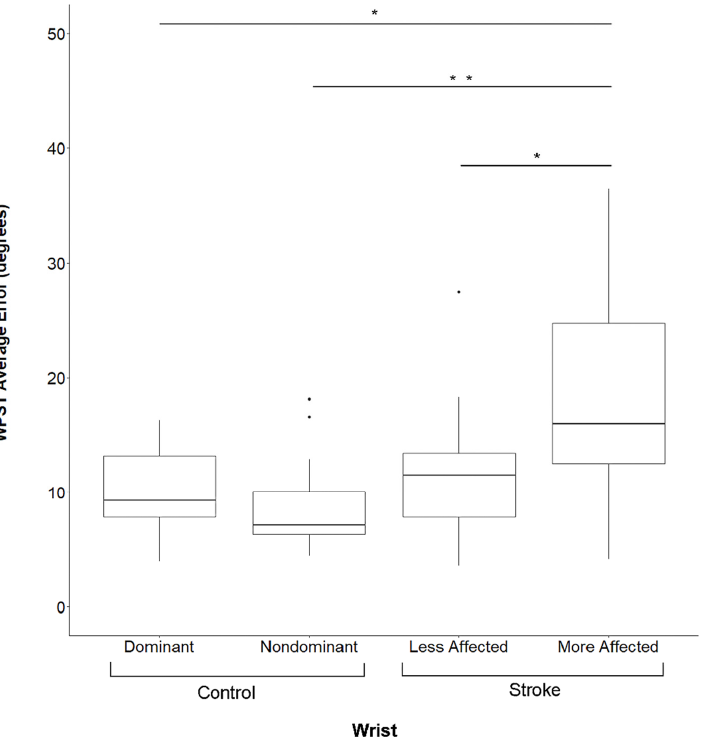
Figure 2. Wrist Position Sense Test Error By Subject Group And Side. Data are for Visit 1. WPST = Wrist Position Sense Test, * significant at p < 0.01 after correction for multiple comparisons, ** significant at p < 0.001 after correction for multiple comparisons, Dots represent outlier data points for respective box and whisker